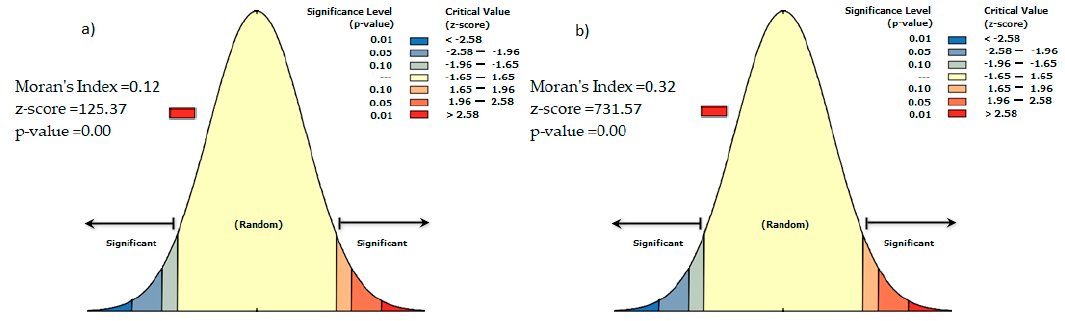
Figure 10. Result of Moran’s I index for ( a ) the Rusle equation and ( b ) the SWAT